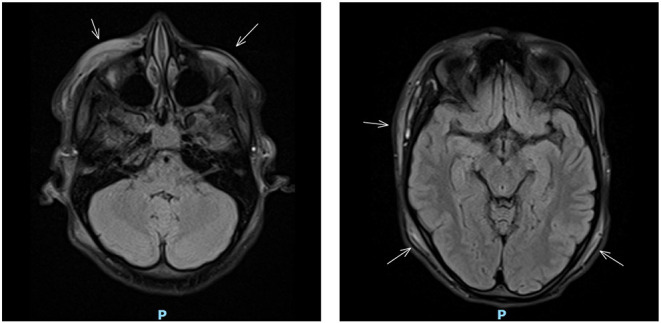
Cranial MRI showing diffuse subcutaneous edema (indicated by arrows).